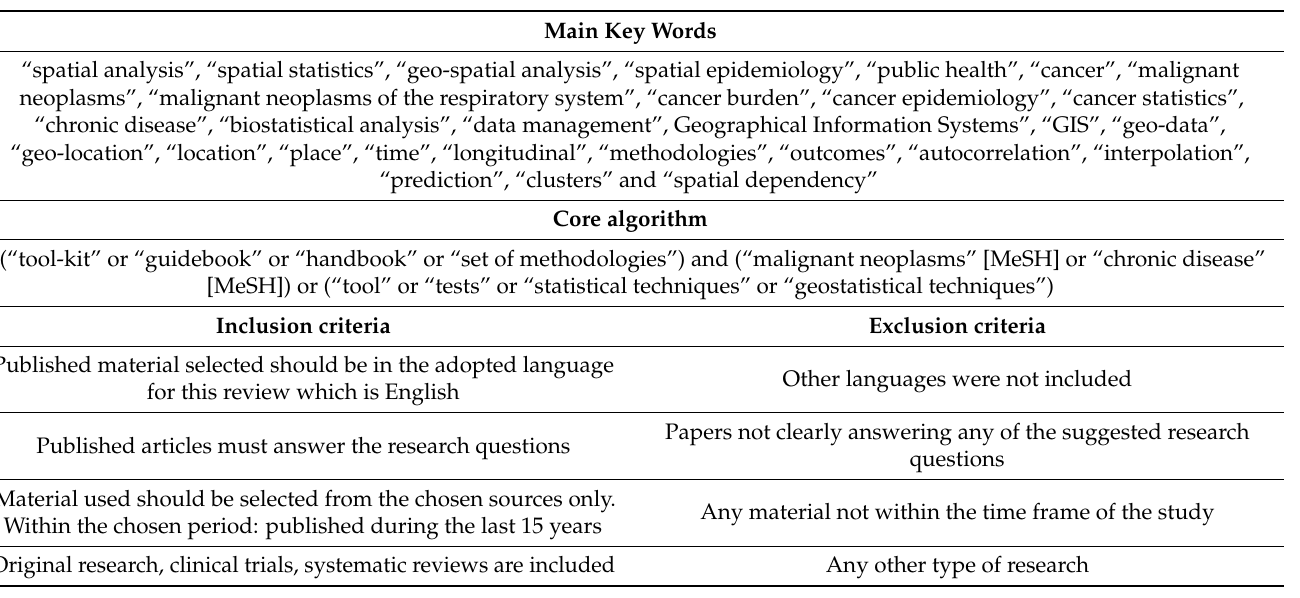
Table 1. Inclusion and exclusion criteria of the systematic